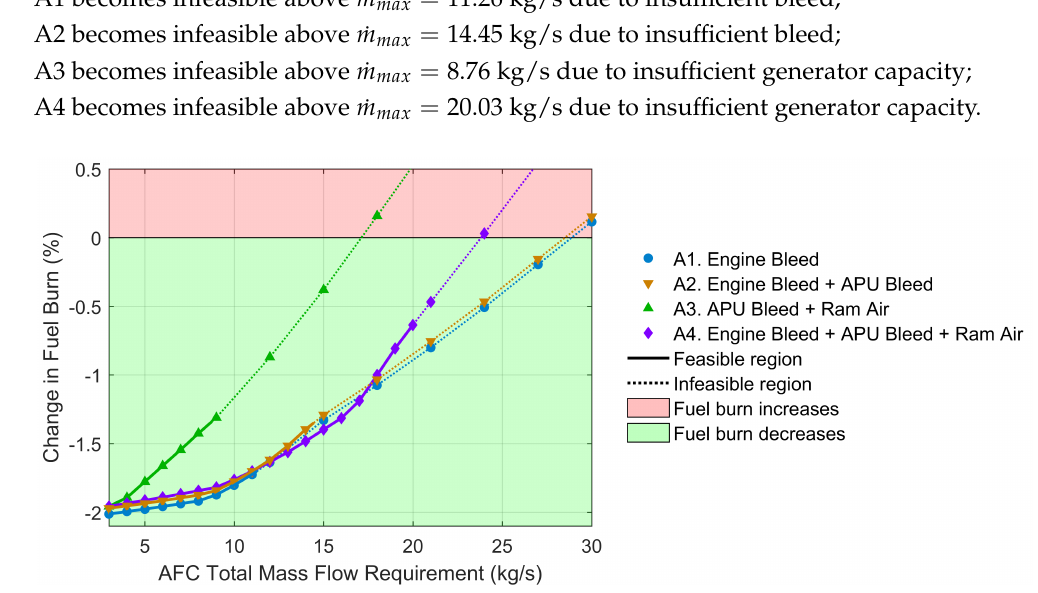
Figure 6. Change in mission block fuel vs. total mass flow requirement for the four HLAFC architectures, evaluated for the reference mission with payload of 28,735 kg and range of 6000 nmi (11,112